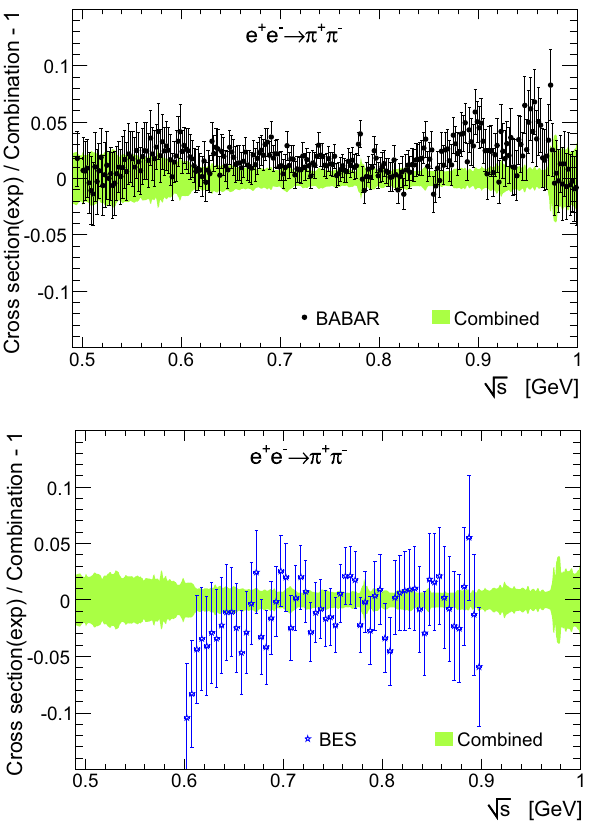
and the HVPTools combination. The error bars include statistical and systematic uncertainties added in quadrature